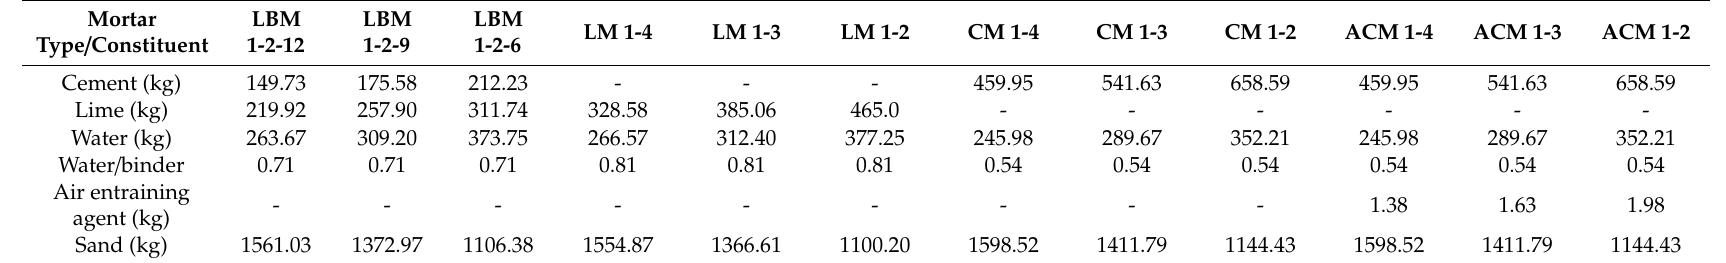
Table 1. The composition of mortar